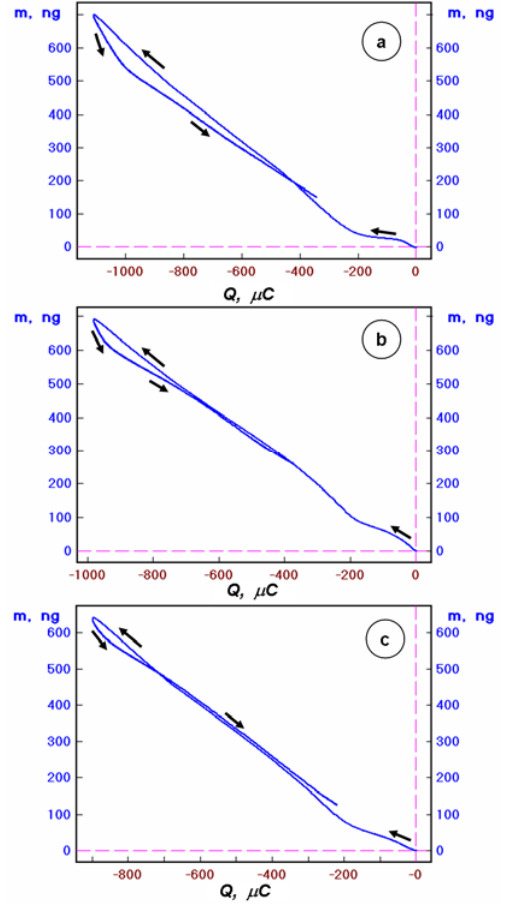
Figure 4. Linear potential scan EQCN plots of mass change vs. charge for: (a) bare Au, (b) Au/CA, and (c) Au/CA-GSH, recorded in 0.1 M NaClO Hg(ClO ) solution, in the potential range from E = +0.9 to 0 V vs. Ag/AgCl, at a scan rate 4 2 v = 50